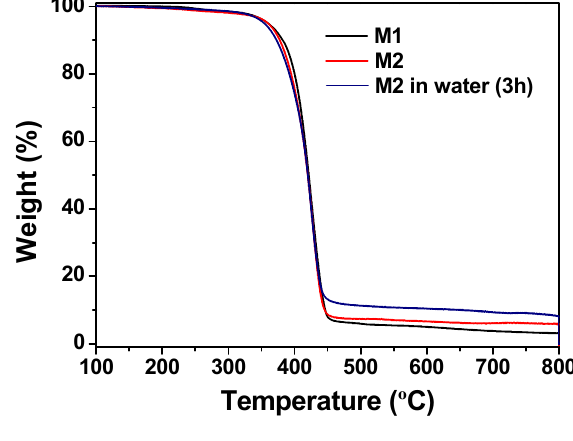
Figure 3. TGA curves of membranes M1 and M2 . The degradation pattern of M2 after a cycle of soaking in pure water for 3 h with subsequent drying at rt is also